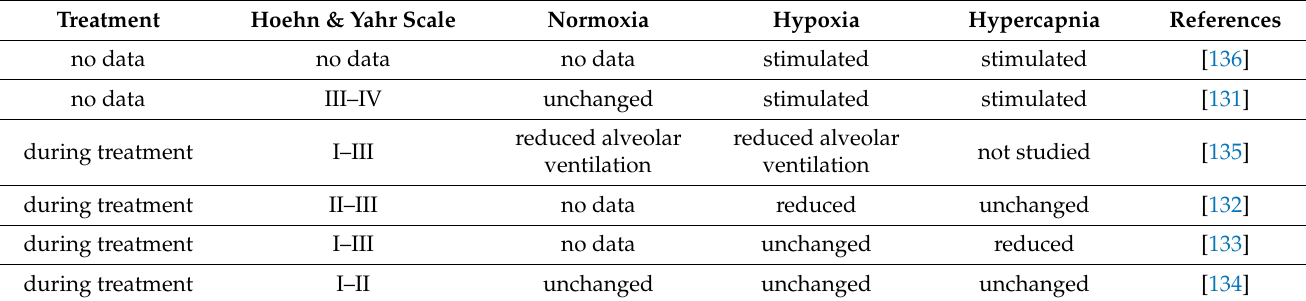
Table 1. Ventilatory responses to hypoxia and hypercapnia in patients with